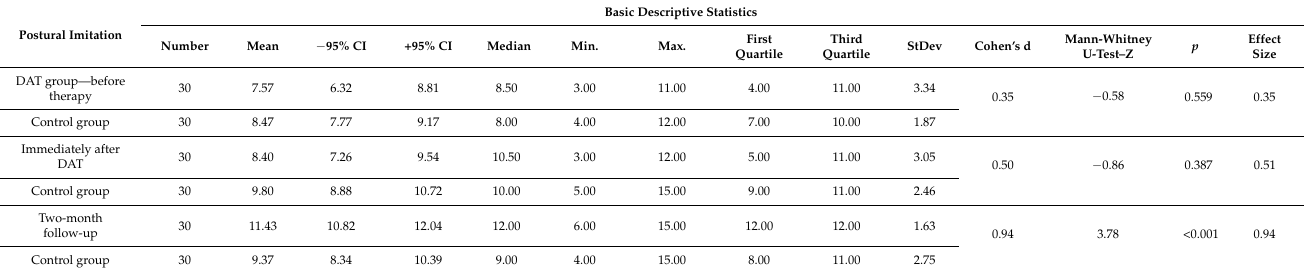
Table 8. Postural imitation—comparison of DAT group scores achieved over time to the results of the controls.